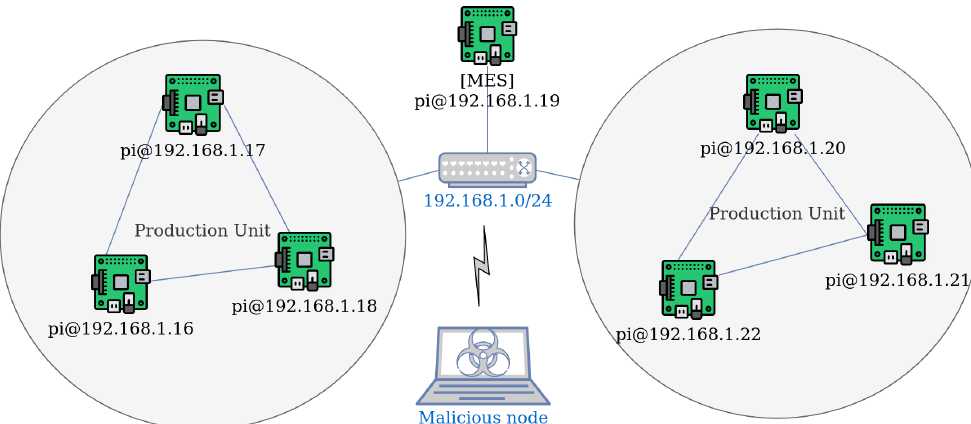
Figure 11. Illustration of the testbed used for the generation of the M2M using OPC UA dataset. Figure obtained from